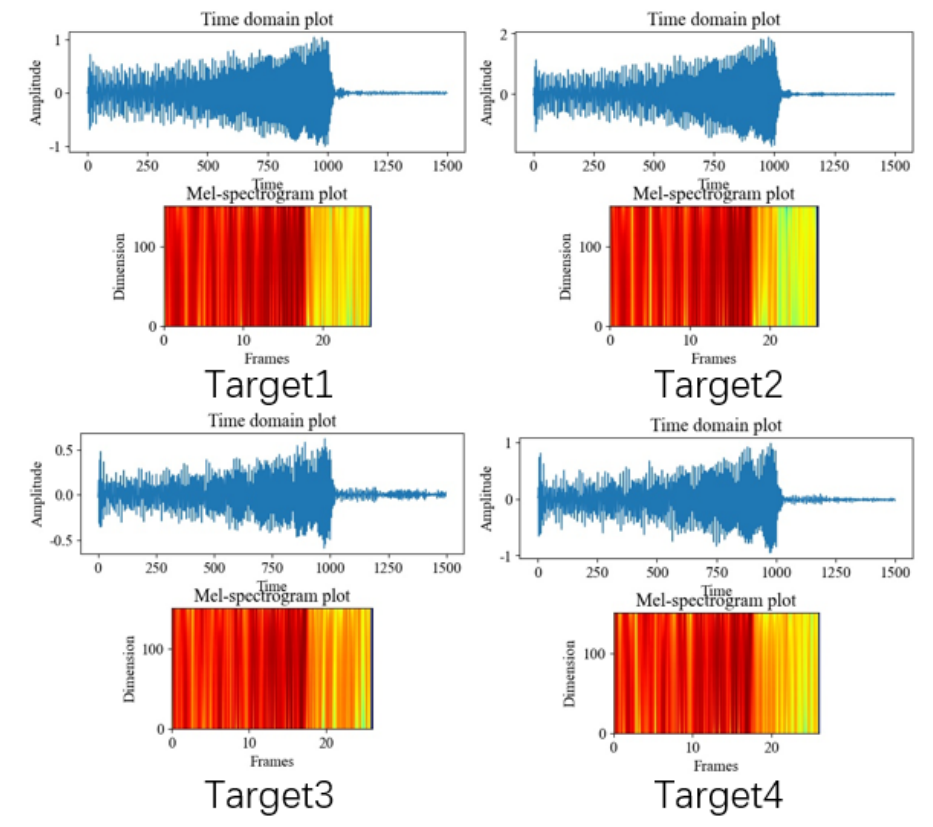
Figure 14. Schematic diagram of the underwater targets’ echoes and Mel-Spectrograms.